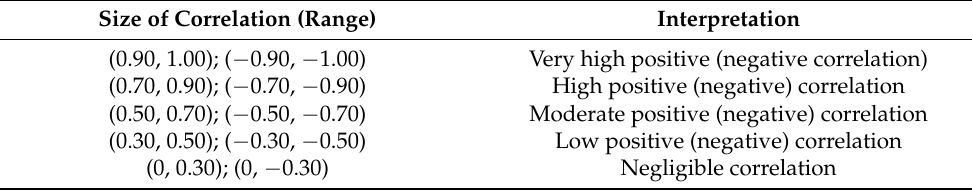
Table 2. Interpreting the size of a correlation coefficient.